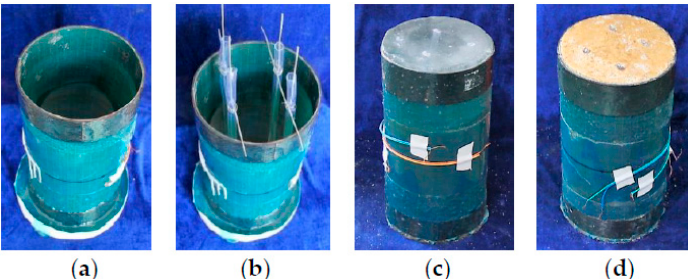
Figure 2. Preparation of plain ice-filled flax fiber-reinforced polymer tubular (PIFFT) and sawdust reinforced ice - filled flax fiber - reinforced polymer tubular (SIFFT) specimens: ( a ) flax fiber - reinforced polymer (FRP) tube; ( b ) placement of hoses; ( c ) PIFFT specimen; and ( d ) SIFFT specimen.